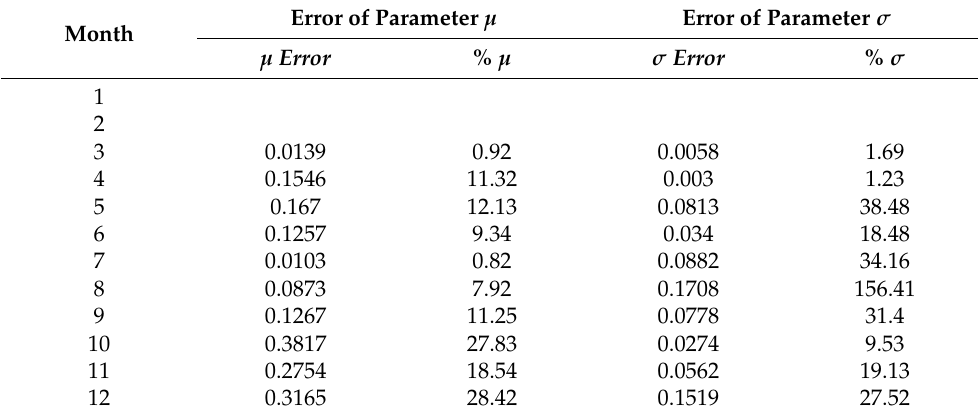
Table 4. Error prediction of the Lognormal pdf